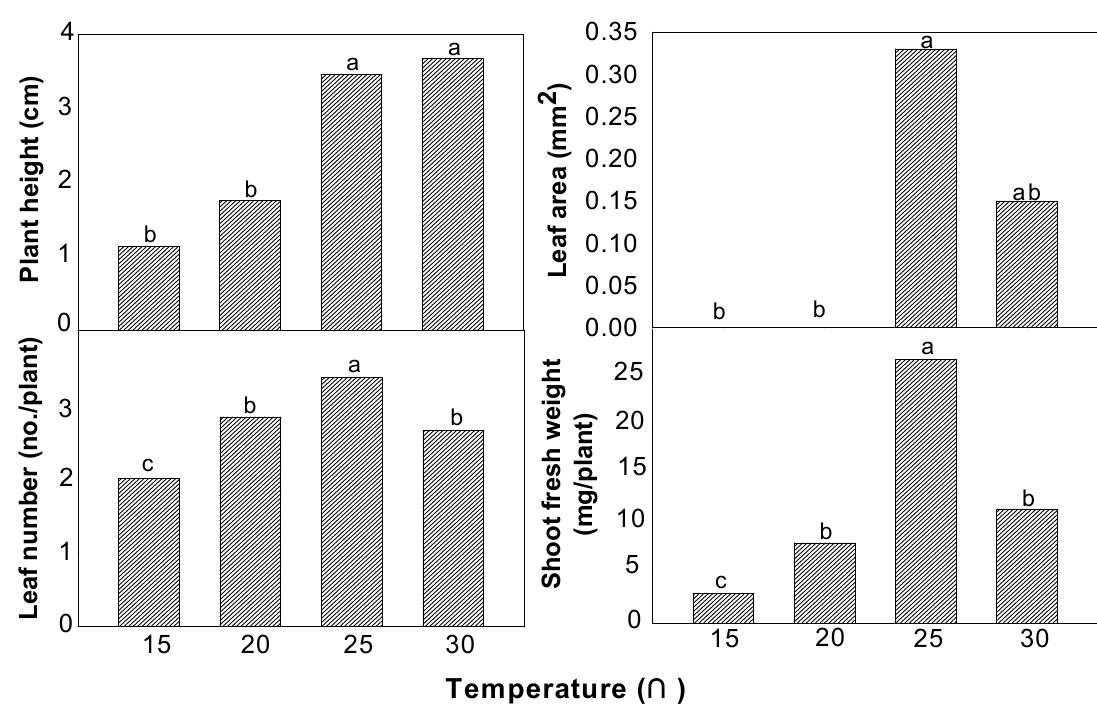
Figure 3. Plant height, leaf number, leaf area, and shoot fresh weight of A. patulus grown at different temperatures in growth chambers. The parameters were measured 17 days after seeding. Means within bars followed by the same letters are not significantly different at the 5% level according to Duncan’s Multiple Range Test.